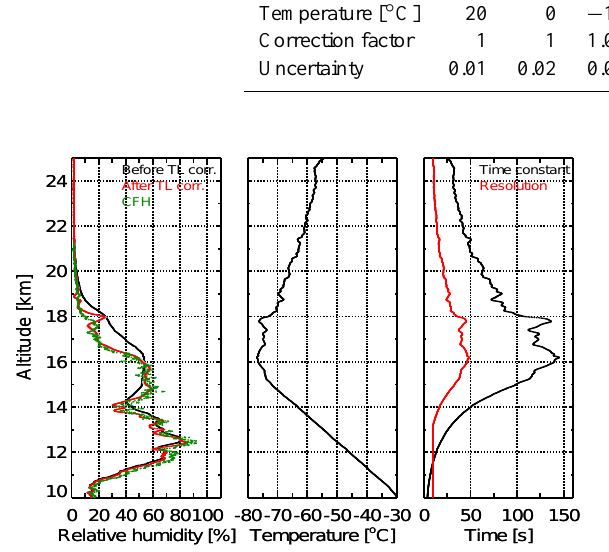
Figure 16. Corrections and their estimated uncertainties to the rela- tive humidity. Left panel: humidity profile. Middle panel: profiles of the corrections for the temperature-dependent calibration cor- rection (black), radiation dry bias (blue), and time-lag (red). The grey trace represents the total correction. Right panel: estimates of the total uncertainty (grey) and the various contributions due to the correction for calibration uncertainty (black), the correction for the temperature-dependent calibration correction (blue), radiation dry bias (red), time-lag constant u(τ) (light blue), and the statistical un- certainty of the time-lag correction (orange). The horizontal dashed line at 16.1km represents the tropopause. Table 4. Estimated sensitivity of the humidity sensor to radiative heating, relative to the temperature sensor. The estimated radiative heating of the temperature sensor, multiplied with the sensitivity factor f , yields the radiative heating of the RS92 humidity sensor. The sensitivity factor depends on production year, the right-most column represents the uncertainty in f